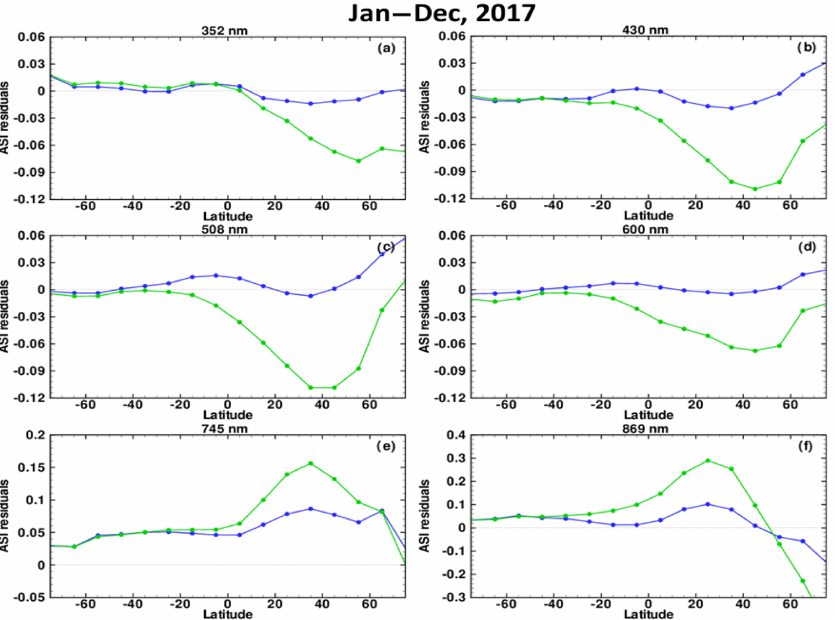
Figure 7. Zonal mean of ASI residuals (ASI m –ASI c ) at 20.5km as a function of latitude for wavelengths at 352, 430, 508, 600, 745 and 869nm for one entire year in 2017. The V1.5 ASD (blue) does a better job in explaining the measured ASI relationship than the V1.0 ASD